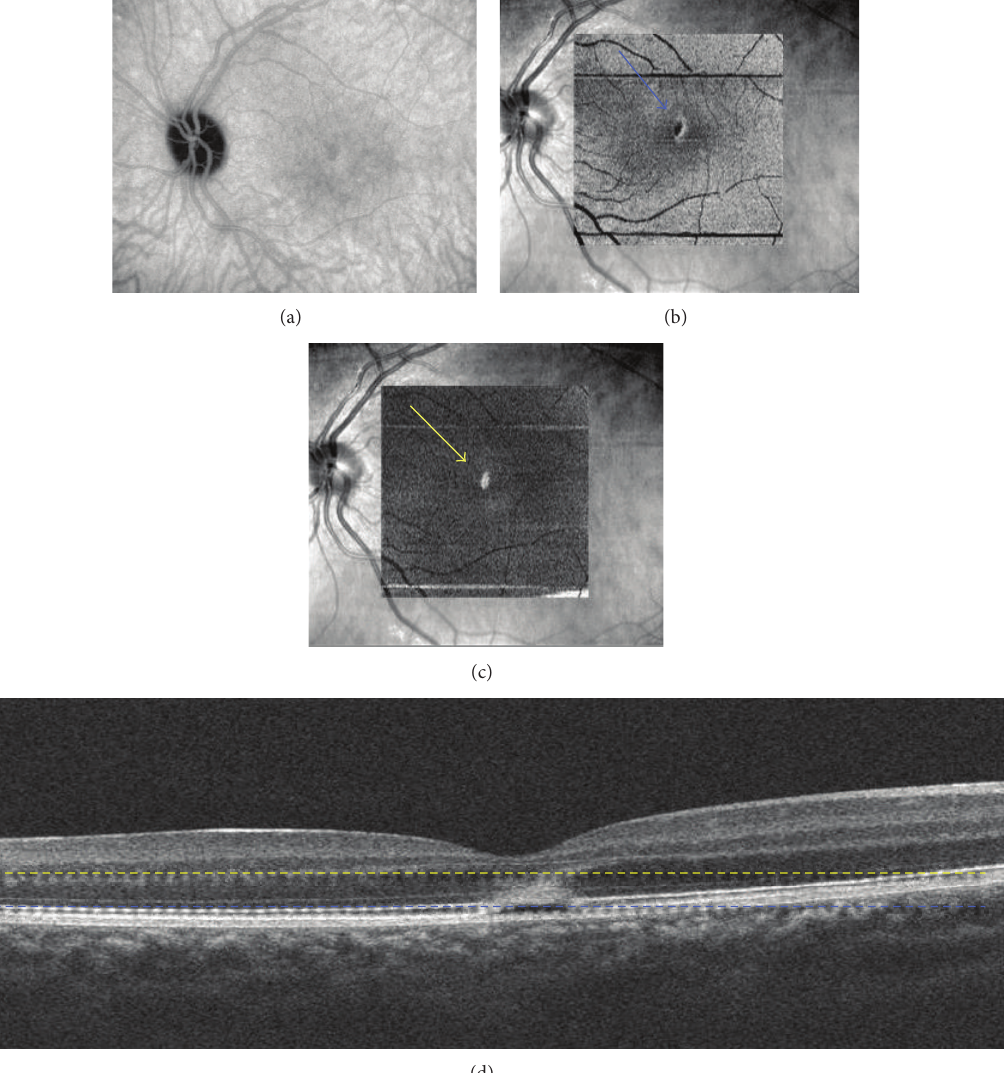
Figure 2: Patient 1, left eye. (a) Indocyanine green angiography (18 minutes), at the initial visit, showing a cockade-like lesion in the macular area at the level of the IS-OS junction. (b) “En-face” spectral-domain optical coherence tomography showing a central cockade-like lesion with a hyporeflective center and a hyperreflective border (blue arrow). (c) “En-face” OCT showing a hyperreflective punctuate lesion located in the outer nuclear layer (yellow arrow). (d) B-scan spectral-domain optical coherence tomography showing hyperreflective edges of the disrupted lesion corresponding with the cockade-like lesion and a hyperreflective lesion in the outer nuclear layer corresponding with the central hyperreflective point on “en-face” OCT (yellow and blue